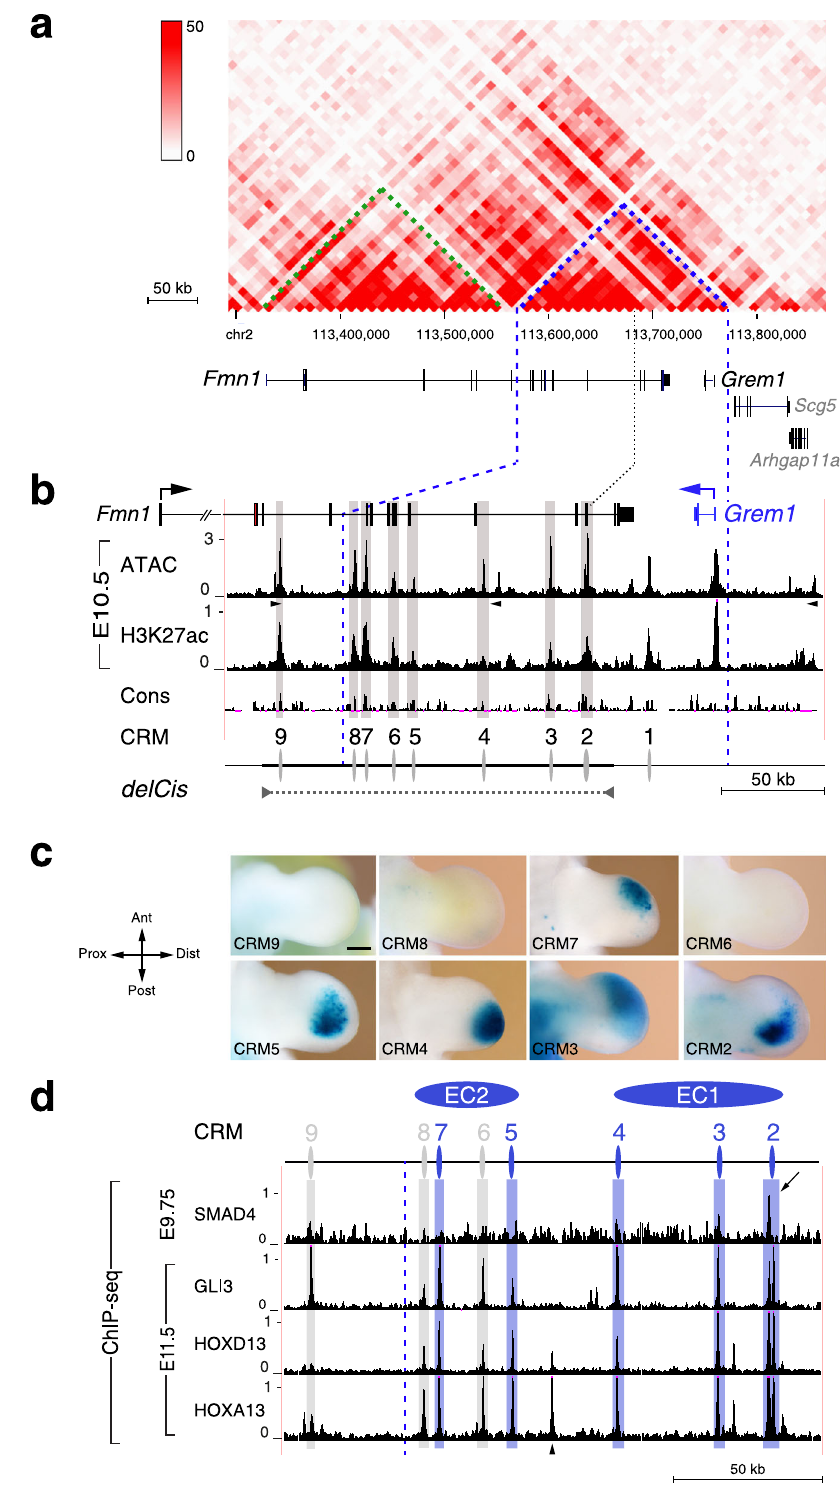
does not globally disrupt the chromatin interactions with the promoter (Fig. 2c). This shows that EC1 and EC2 regions encode all CRMs essential for limb bud mesenchymal Grem1 expression (Fig. 2a – c). Deleting either EC2 or EC1 reduces Grem1 transcript levels during forelimb bud outgrowth (E11.0) by ~50% in both cases (panel RT-qPCR, Fig. 2d, e). However, comparative RNA in situ hybridisation analysis reveals spatio-temporal Grem1 expression differences during limb bud development (Fig. 2b –